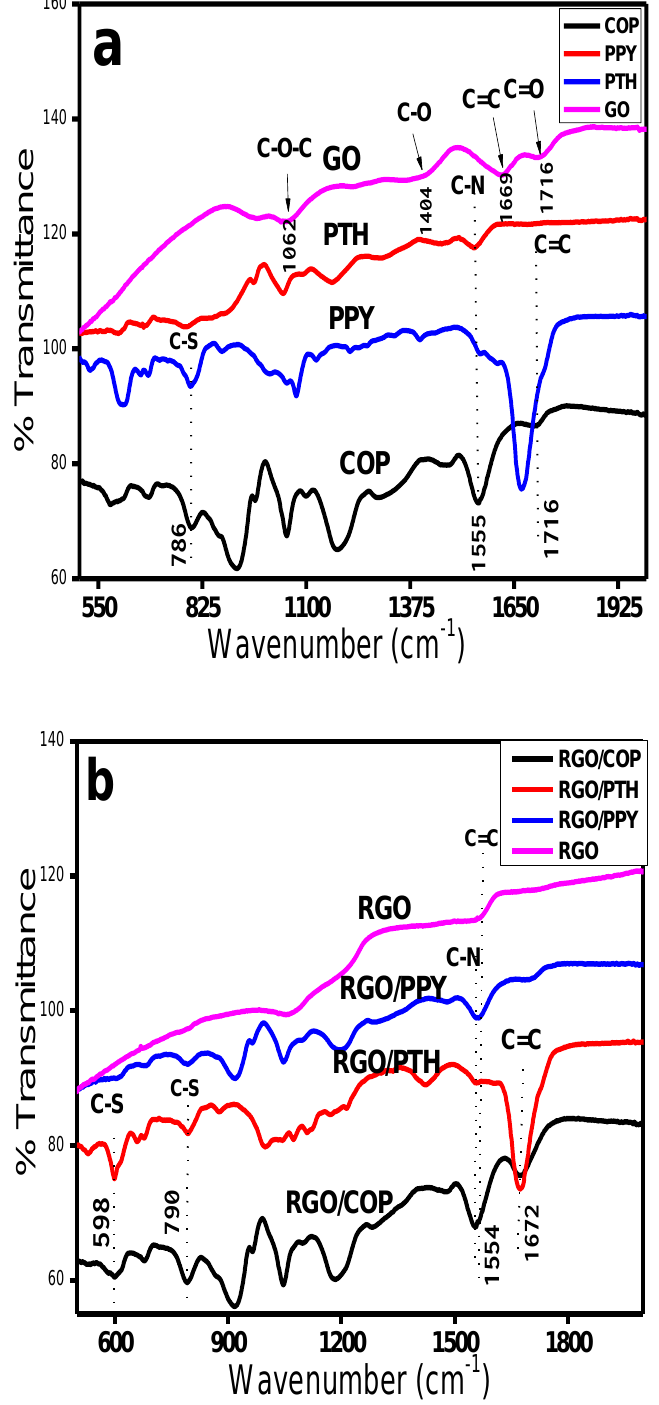
Figure 2. Fourier-transform infrared (FTIR) Spectra of ( a ) GO, COP, PPY, and PTH. ( b ) RGO, RGO/PPY, RGO/PTH, and